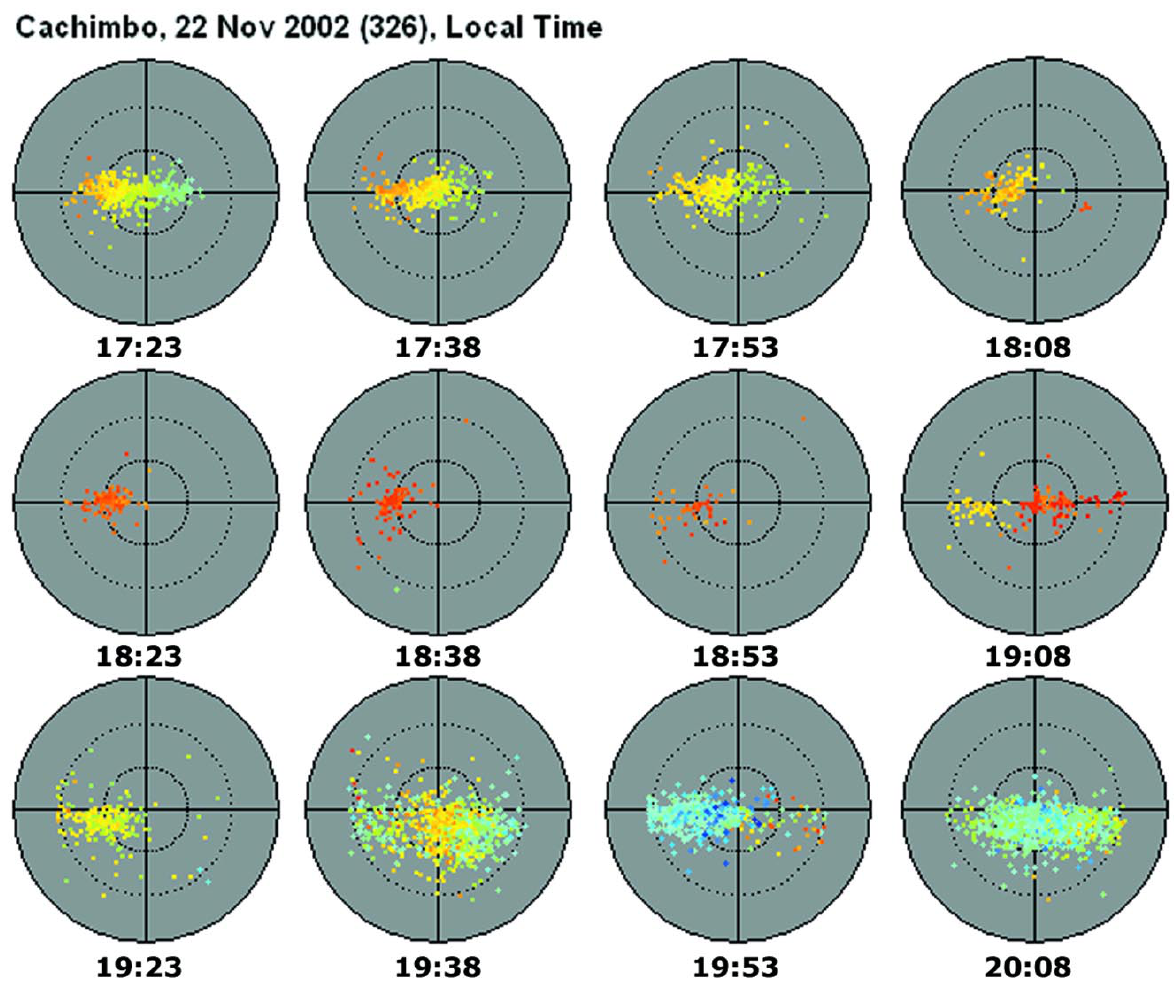
Fig. 5. Skymaps for Cachimbo on 22 November from 17:23 LT to 20:08 LT, showing the effect of the terminator passing at ∼ 18:00 LT. Figure 5. Skymaps for Cachimbo on November 22 from 1723 LT to 2008 LT, showing the effect of the terminator passing at ~1800 LT.